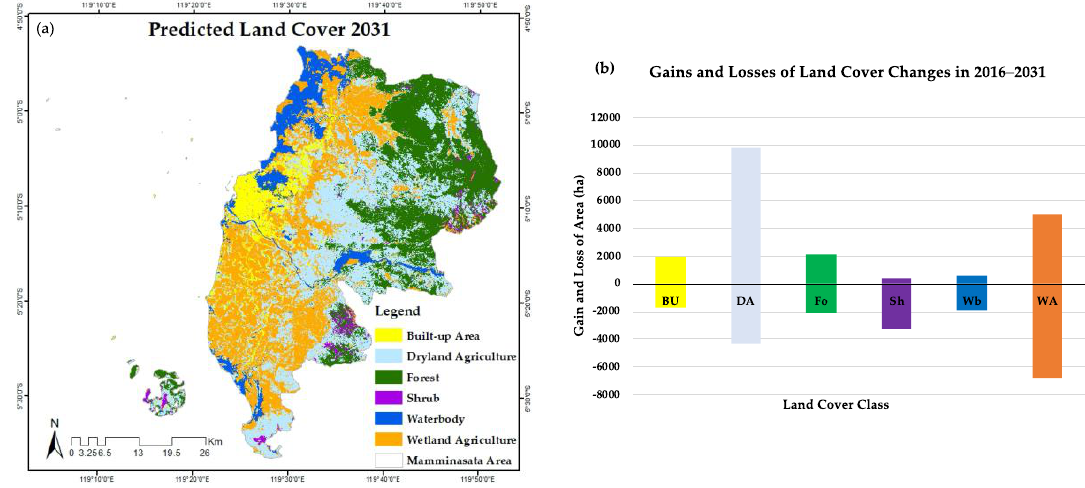
Figure 10. Land cover prediction for 2031 ( a ); land cover changes distribution of the research site in